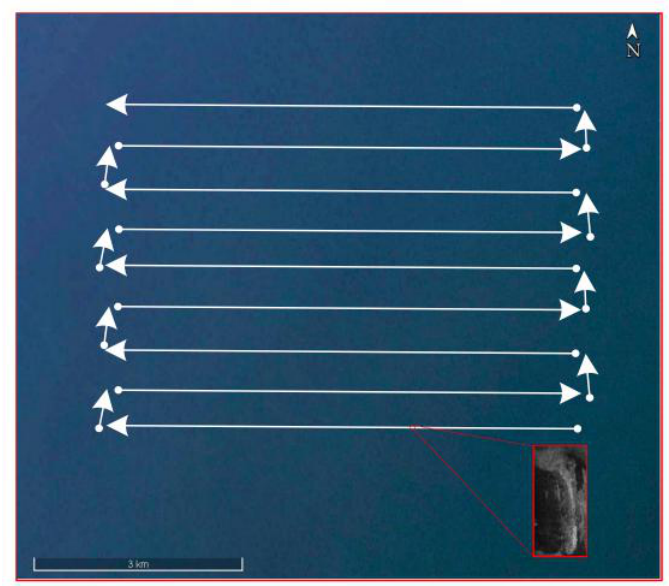
Figure 22. The recognition result of the shipwreck target.